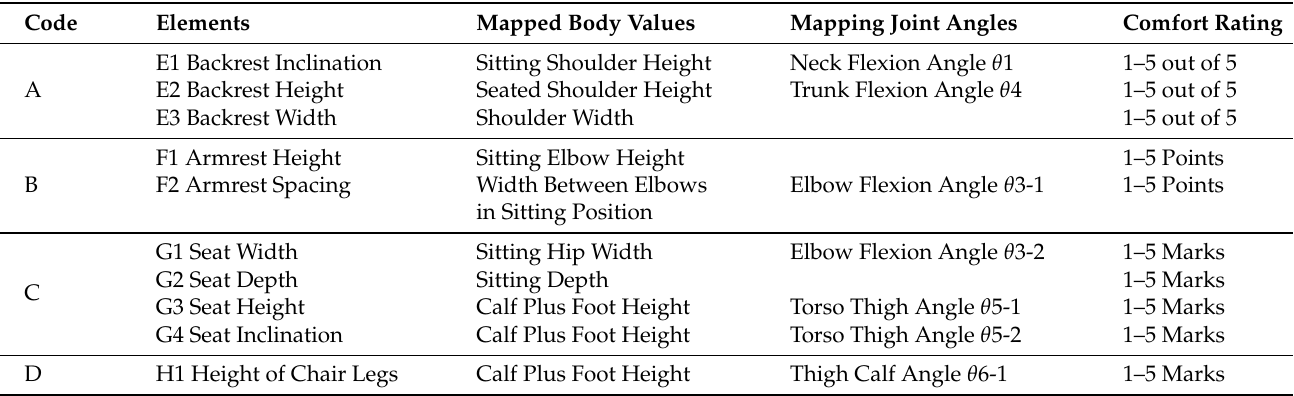
Table 4. Mapping relationship between seat comfort and joint angle. A is the backrest, B is the armrest, C is seat surface, D is leg.